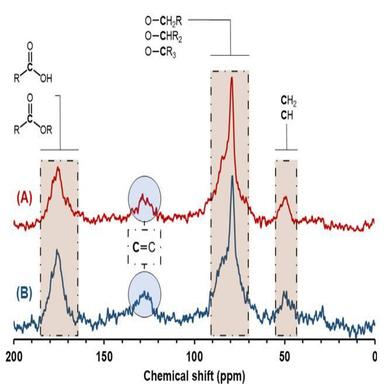
Solid-state 13C NMR spectrum of Bent-AA-PE1 (A) and Bent-AA-PE6 (B) (400 MHz).